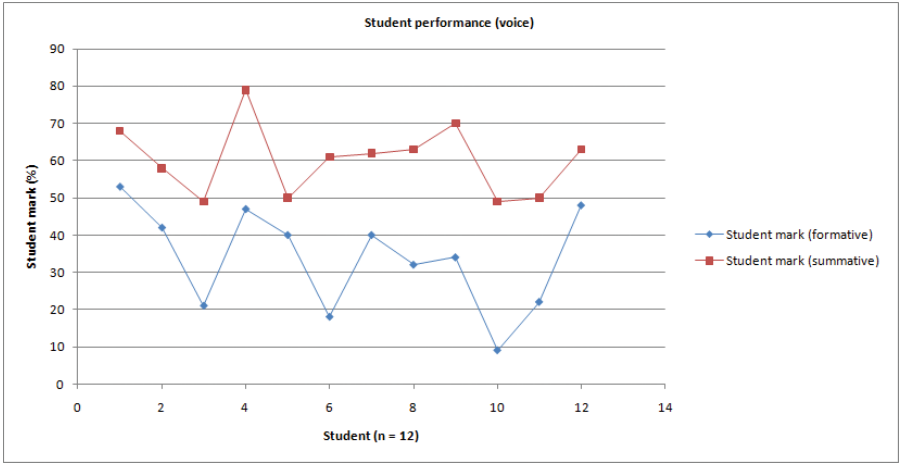
Figure 3. Student performance in formative and summative assessment